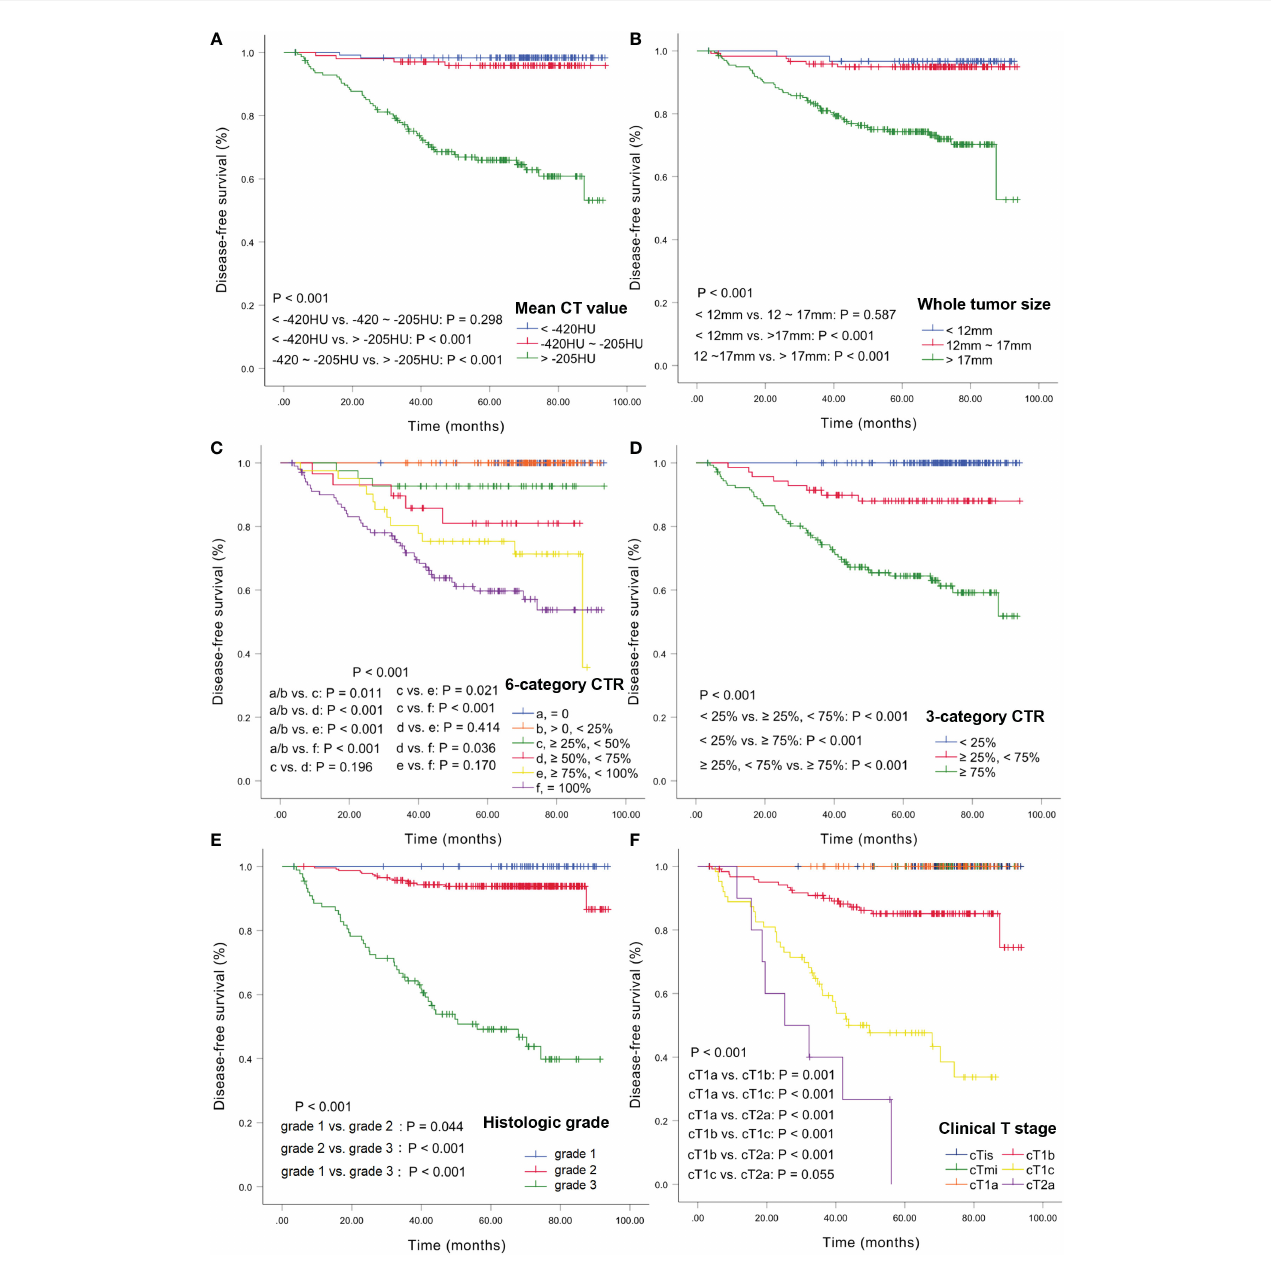
FIGURE 3 Kaplan-Meier estimates of DFS. DFS curves according to CT values (A) , whole tumor size (B) , 6-category CTR (C) , 3-category CTR (D) , histologic grade (E) , and clinical T stage (F) . DFS, disease-free survival; CTR, consolidation tumor